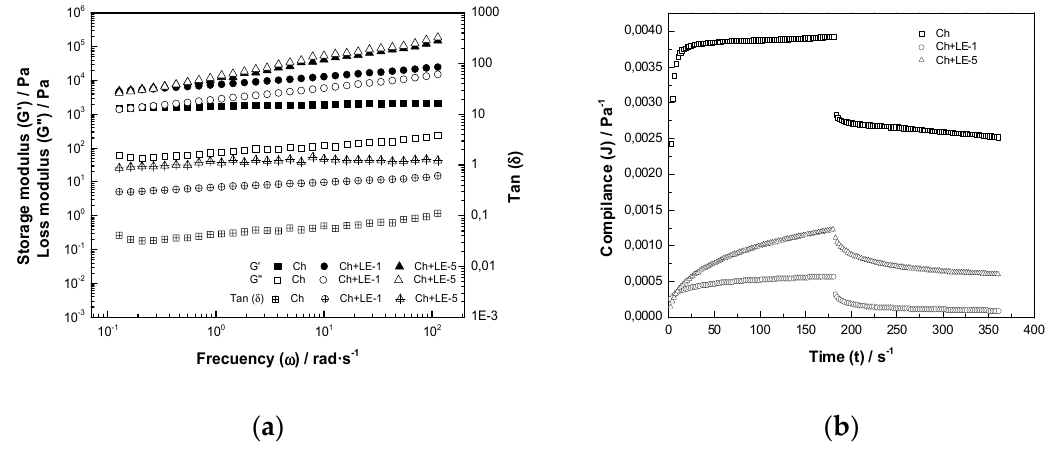
Figure 4. Rheological properties of chitosan and chitosan-licorice edible films: ( a ) frequency sweep and ( b ) creep and recovery.